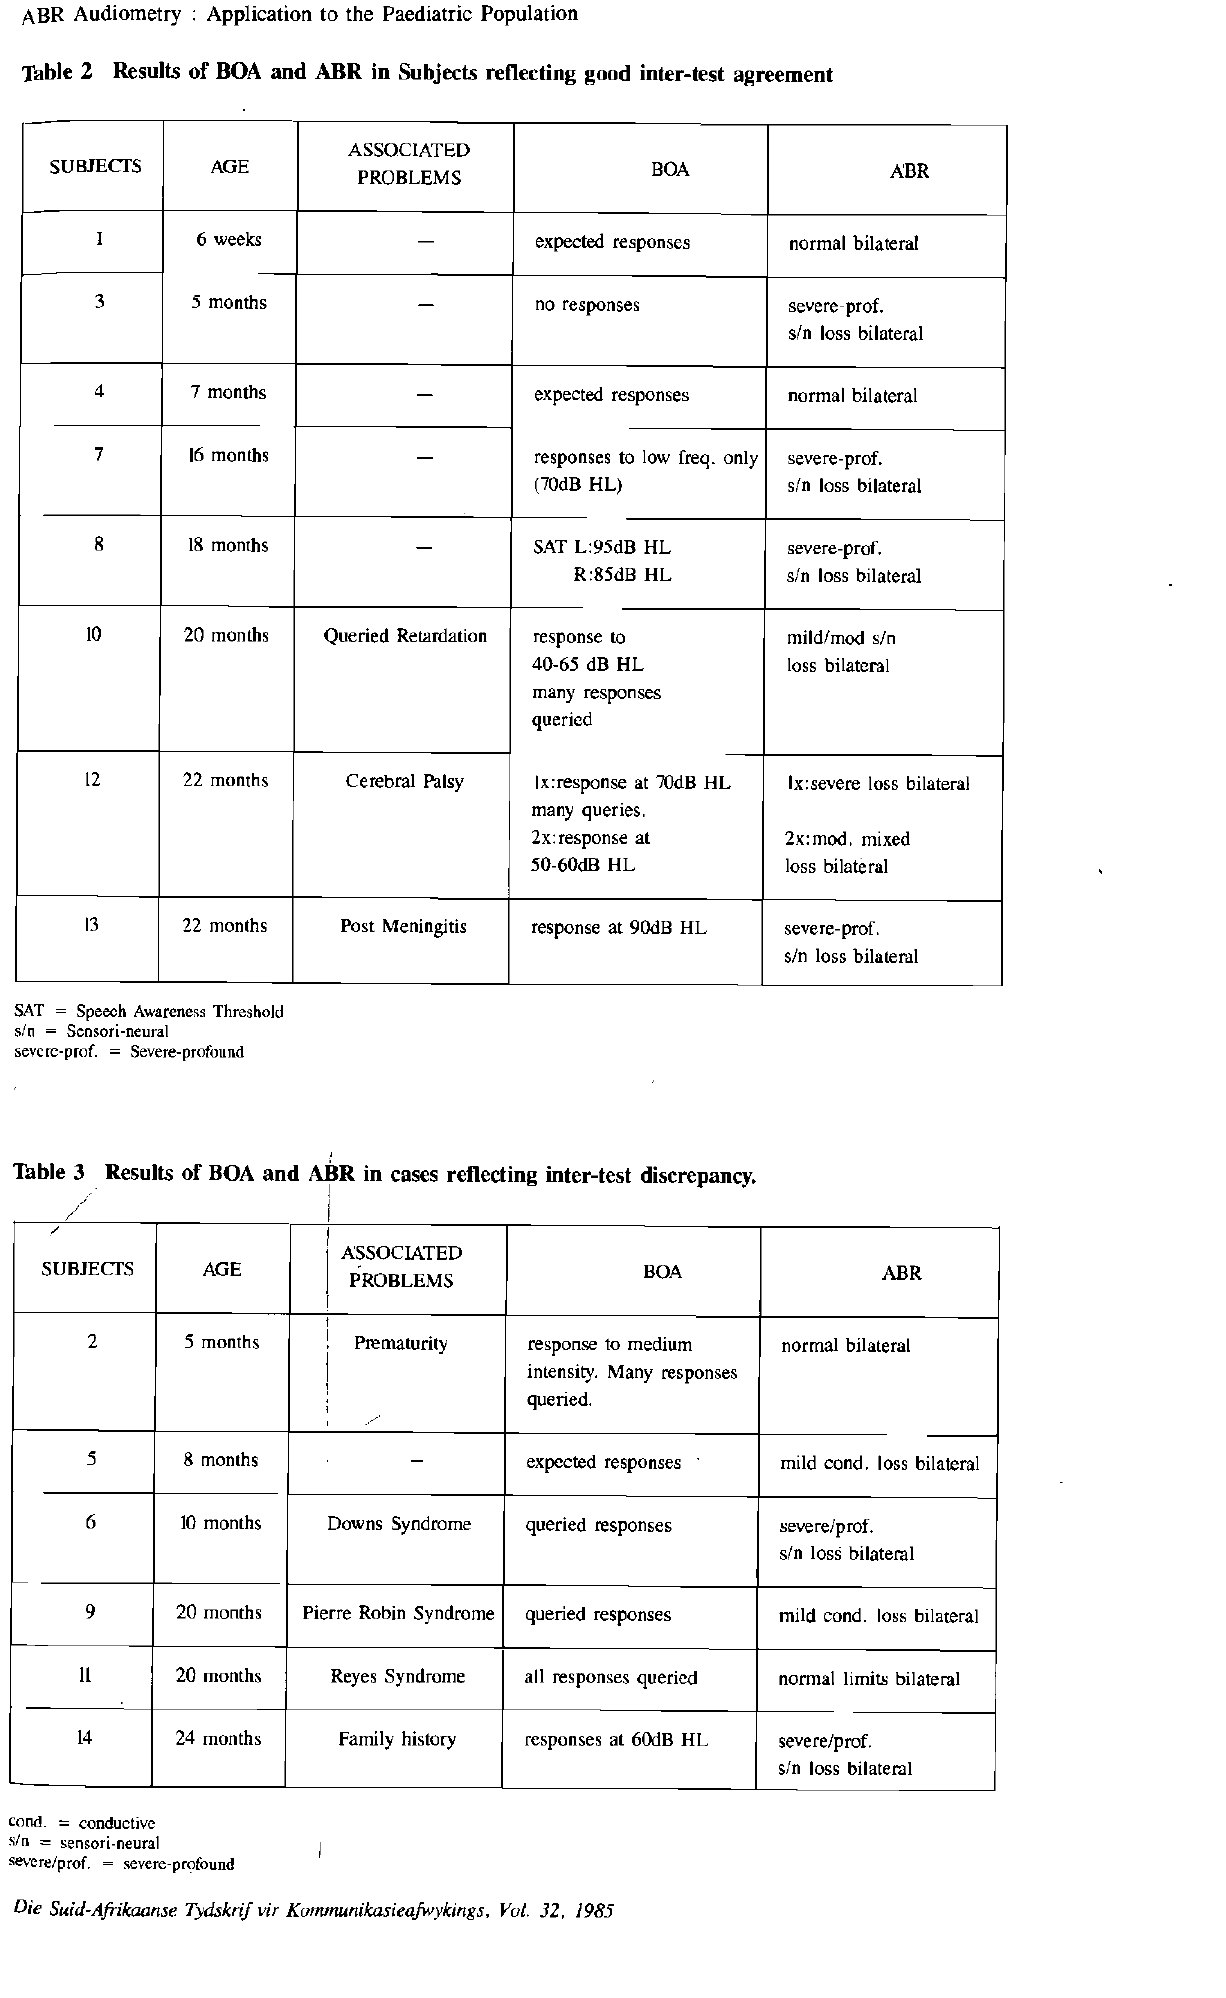
Table 2 Results of BOA and ABR in Subjects reflecting good inter-test